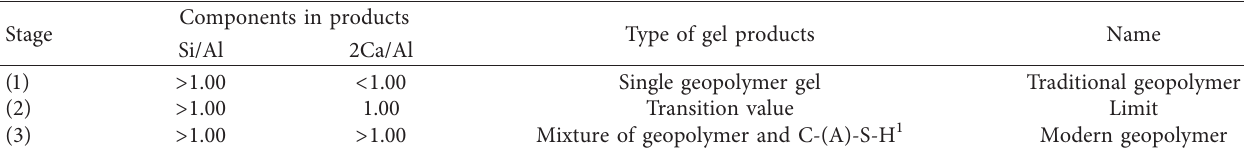
Table 2: The quantitative determination of the gel products for alkali-activated fly ash-based composites (AAFC) with calcium additives by the chemical components in products.